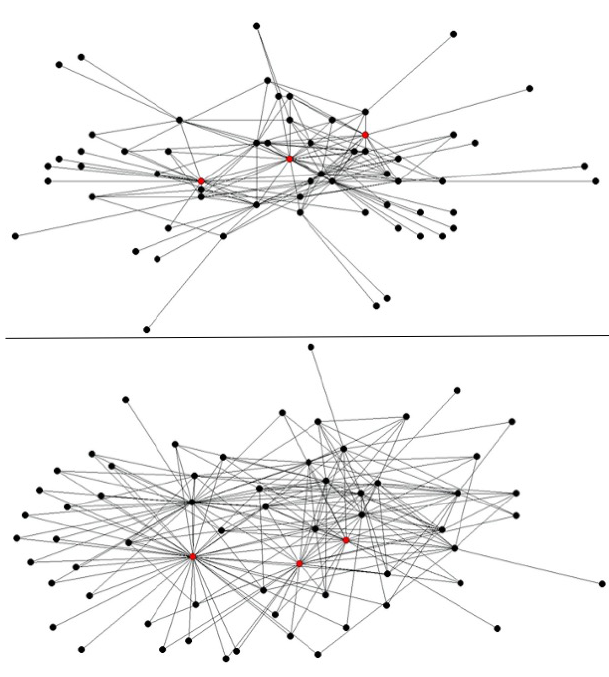
Fig. 4. Cooperation network for the Northern Plains (top) and Eastern Plains (bottom) displayed in Netdraw (Borgatti et al. 2002). Key players in each network identified in